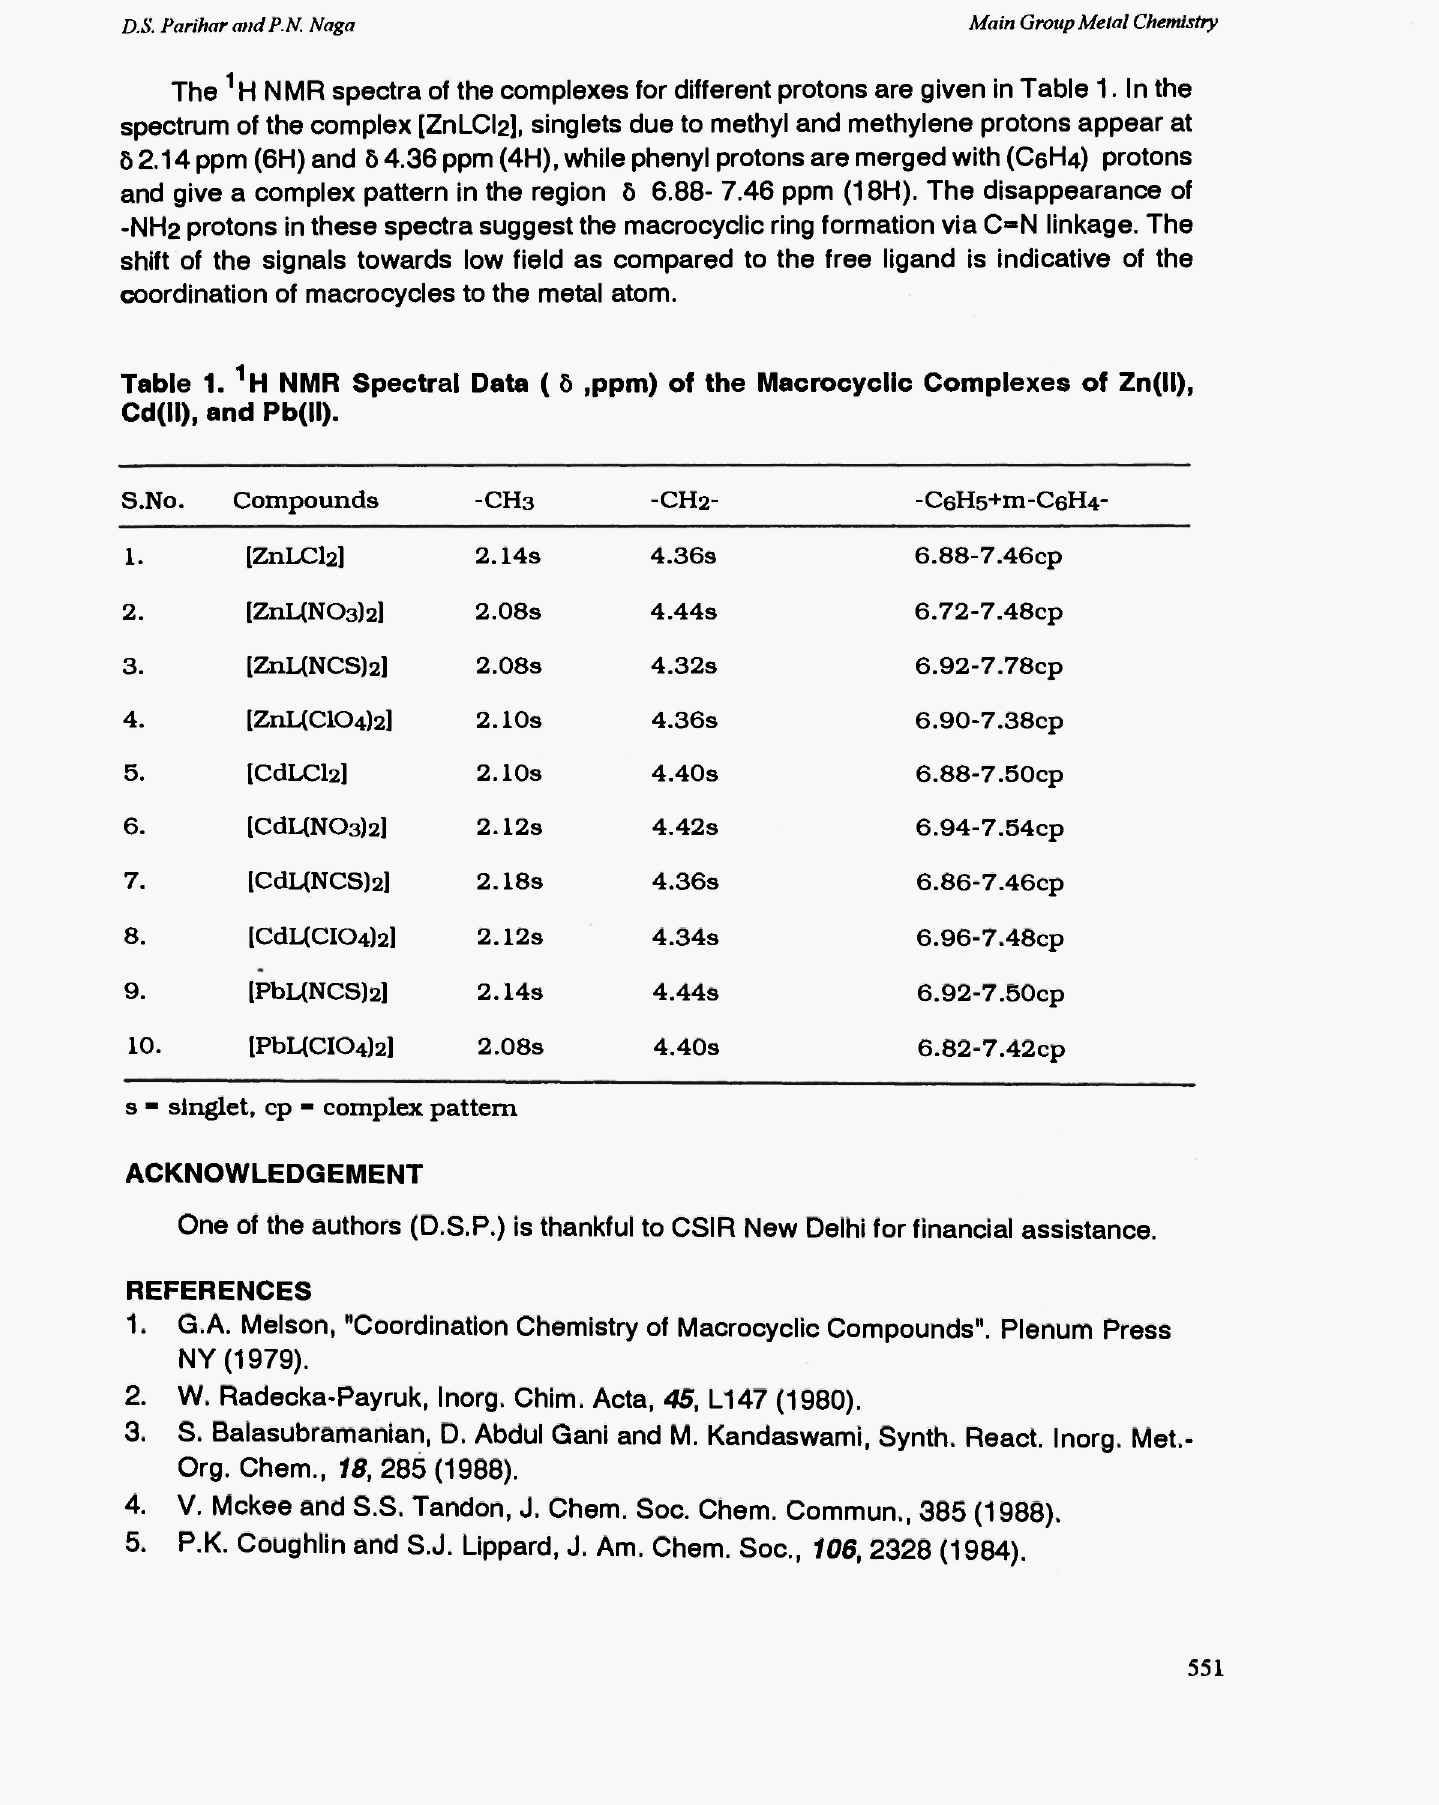
Table 1. 1 H NMR Spectral Data ( δ ,ppm) of the Macrocyclic Complexes of Zn(ll), Cd(ll), and